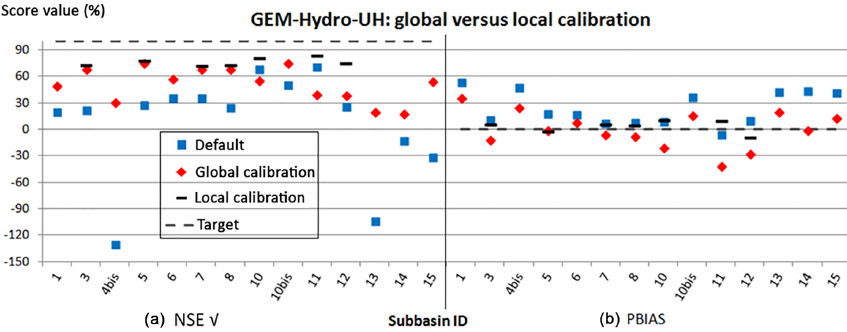
Figure 7. GEM-Hydro-UH performances in validation for the 14 GRIP-O gauged subbasins (Fig. 2) with default, locally and globally calibrated parameter values. Perfect scores are shown. Results are presented as NSE